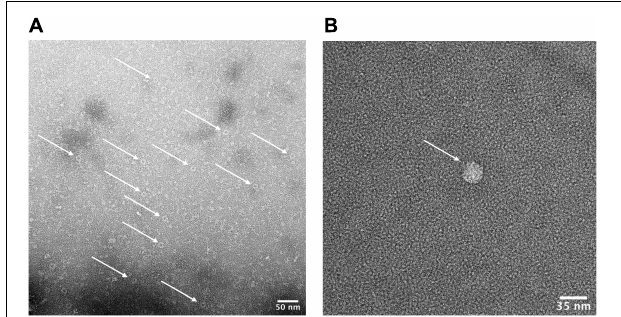
FIGURE 7 | Characterization of HBc VLPs obtained from a heat-treatment and ammonium sulfate purification method. Images generated using transmission electron microscopy (TEM). (A) Samples were prepared directly from material resuspended after ammonium sulfate precipitation. The arrows indicate a number of fully formed HBc VLPs. Scale-bar size: 50 nm. (B) Sample was prepared at a lower concentration of 5 µ g ml − 1 . Staining was preceded by three immediate washes in filtered distilled water after the sample was applied to the grid. The arrow indicates a fully formed HBc VLP. Scale-bar size: 35